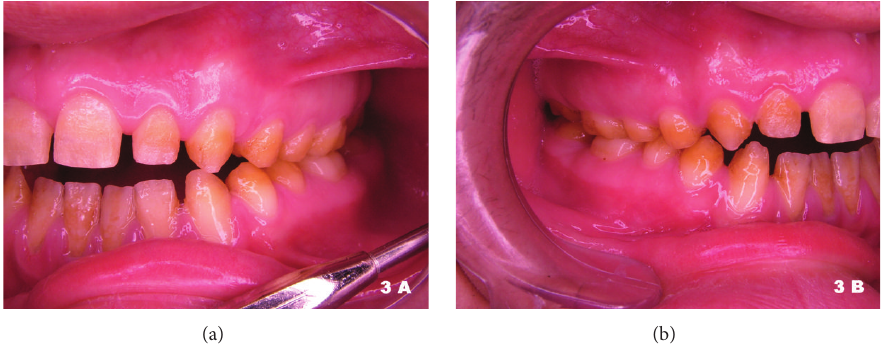
Figure 3: Intraoral lateral view of the teeth before treatment.